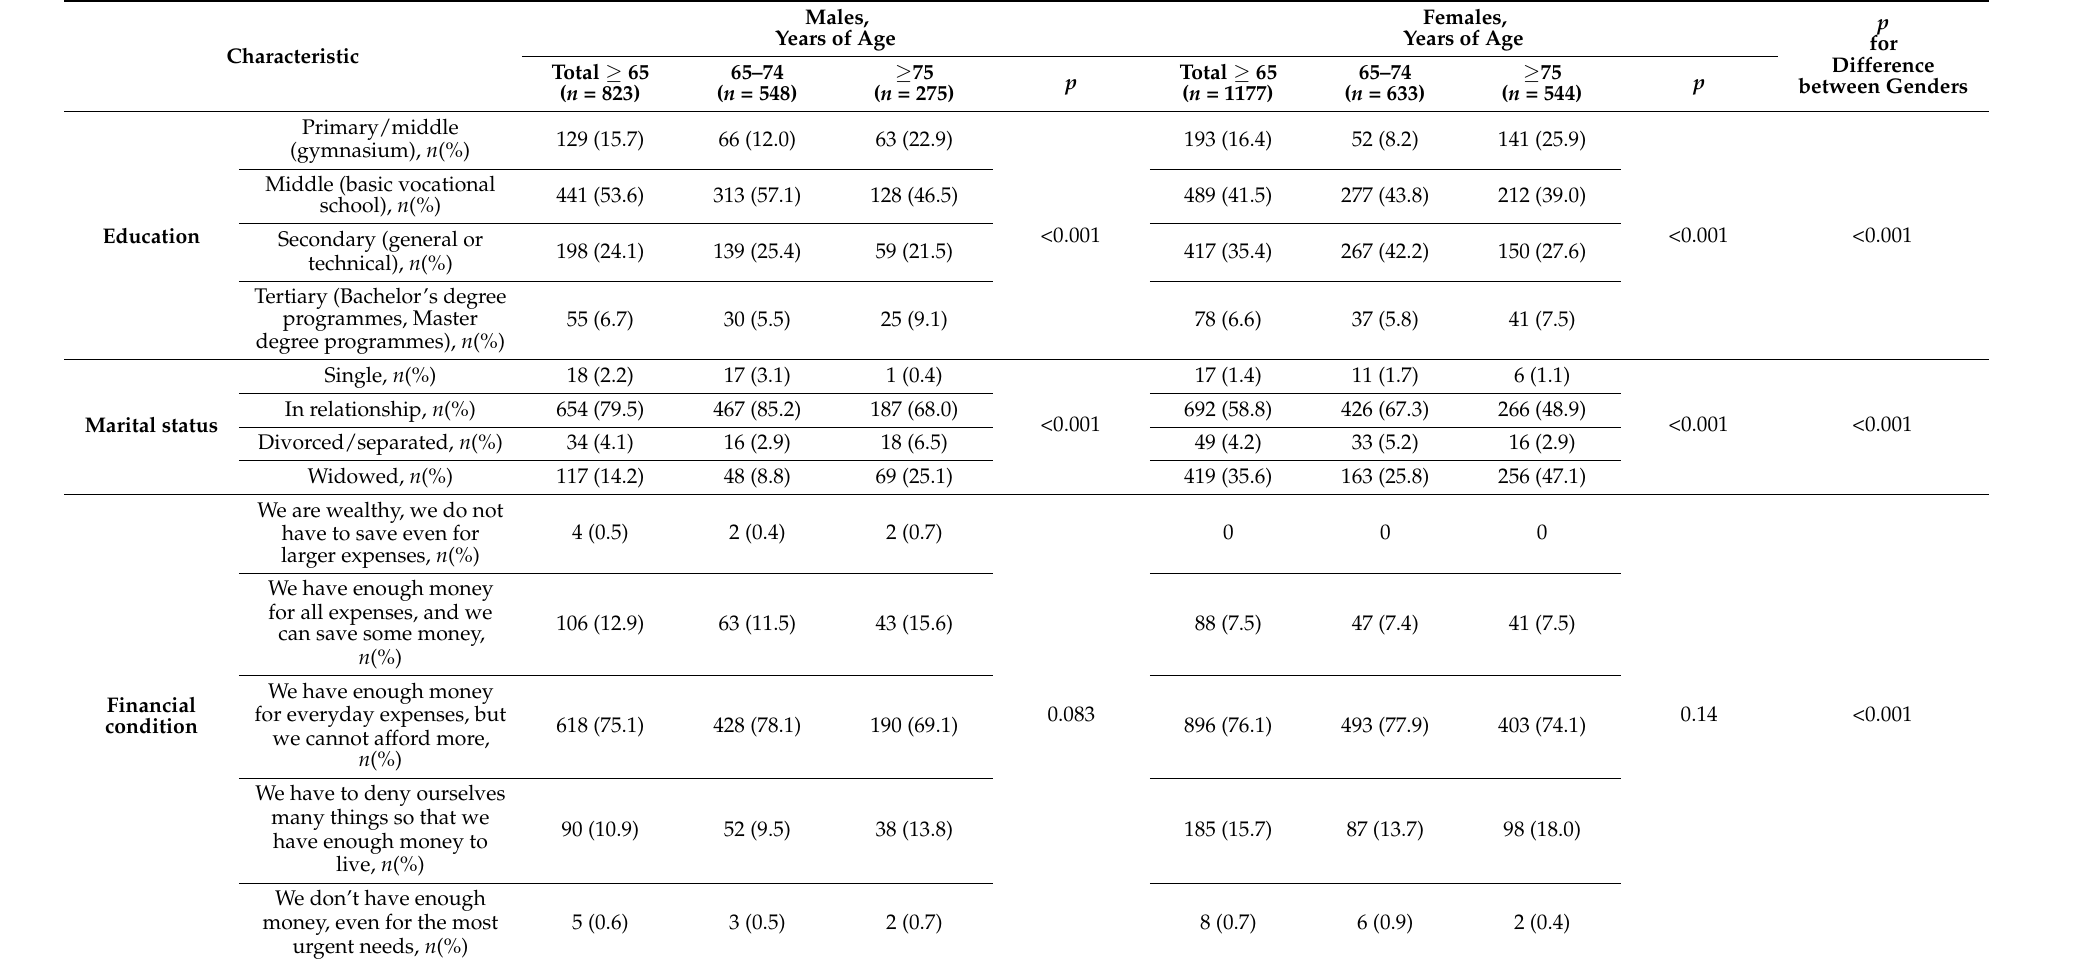
Table 1. Demographic characteristics of the study group, divided into age groups, n